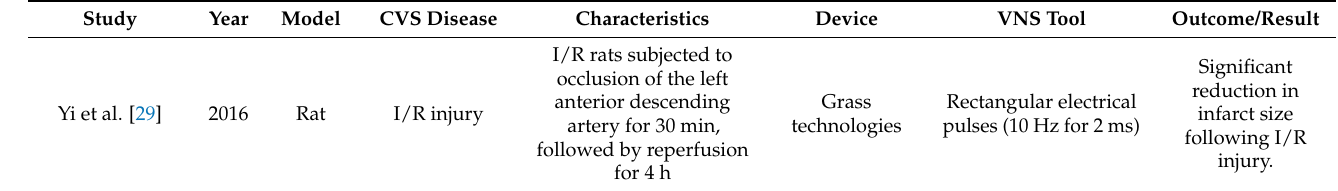
Table 1. Studies on VNS usage for myocardial infarction (N/A—Not Available, I/R—Ischemia Reperfusion, VNS—Vagus Nerve Stimulation, MI—Myocardial Infarction, LV—left ventricle, TNF α —Tumor Necrosis Factor